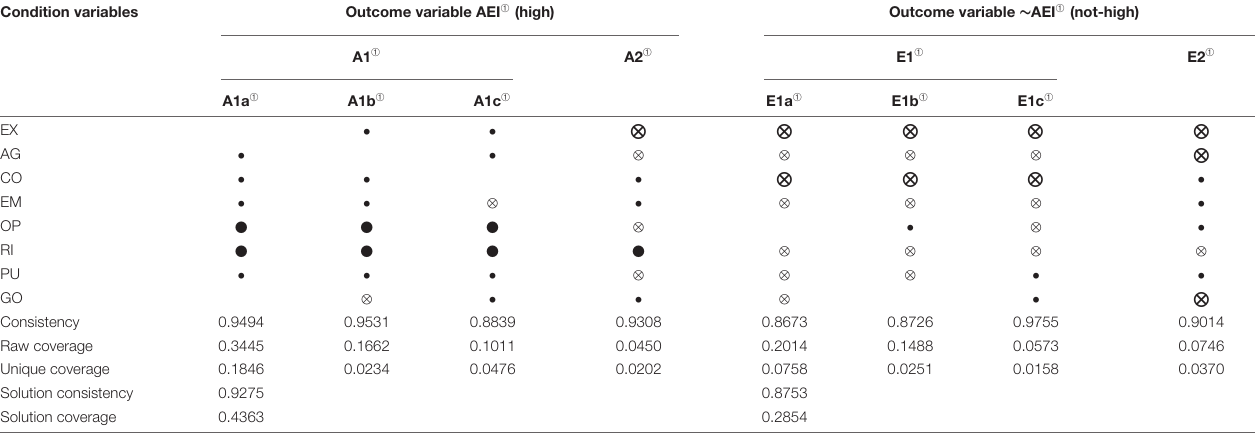
TABLE 6 | Configuration of high and not-high academic entrepreneurial intention for robustness analysis (other conditions remain unchanged, and the consistency threshold was 0.85). Condition variables Outcome variable AEI (cid:192) (high) Outcome variable ∼ AEI (cid:192)